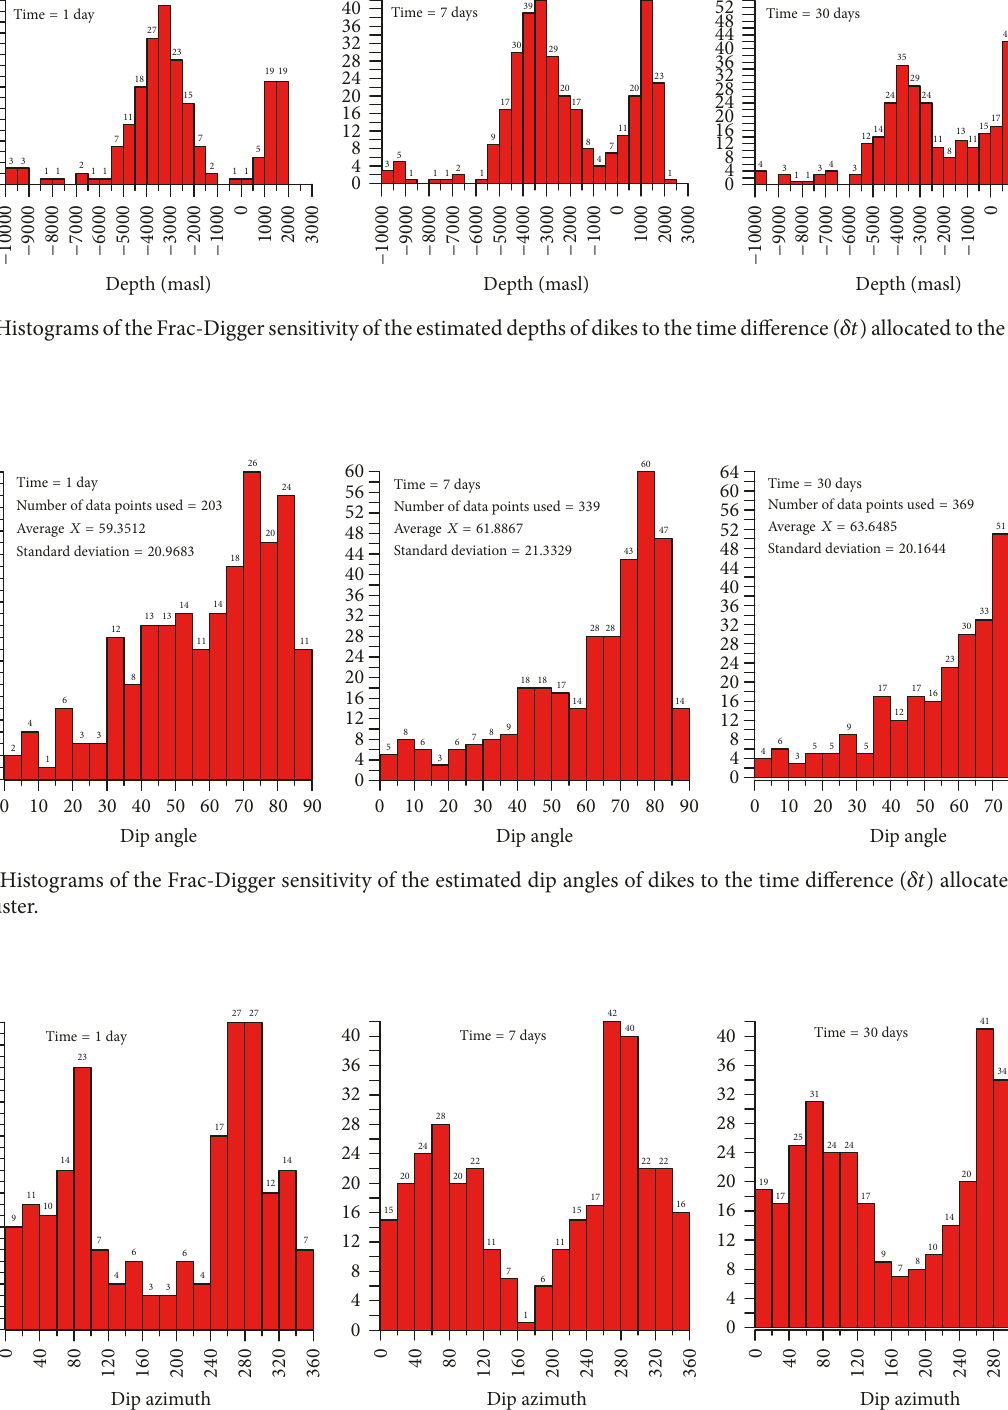
Figure 39: Histograms of the Frac-Digger sensitivity of the estimated dip azimuths of dikes to the time difference ( 𝛿𝑡 ) allocated to the plane- oriented